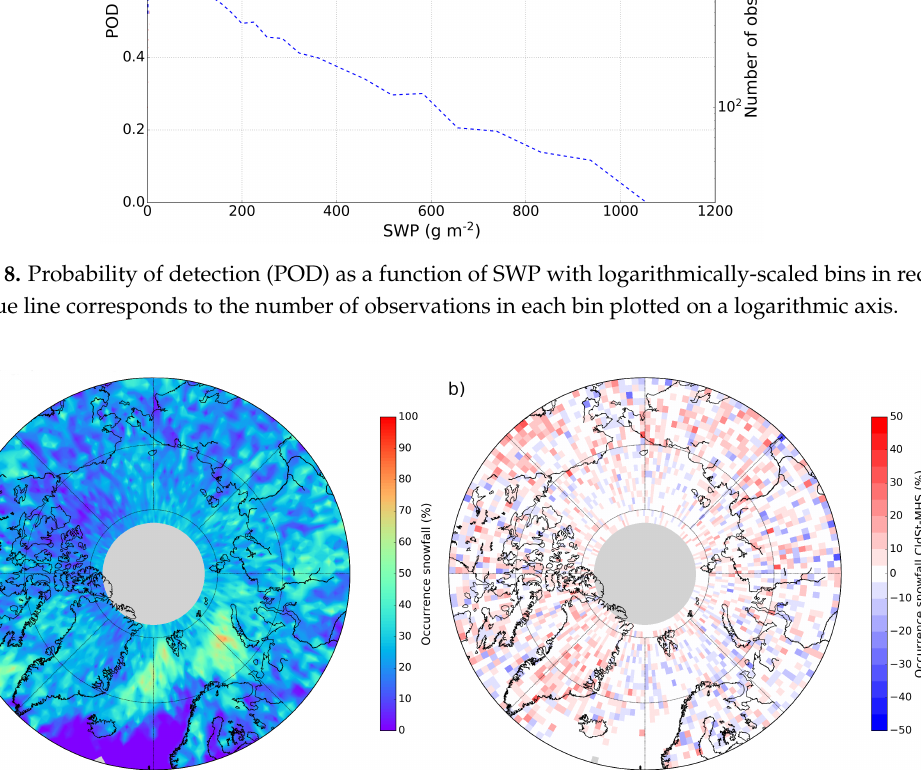
Figure 9. ( a ) The snowfall occurrence obtained using the MHS algorithm. The snowfall occurrence is defined as the number of algorithm-detected snowfall profiles divided by the total number of profiles (%) over a 1 ◦ latitude × 2 ◦ longitude grid. Grey cells are plotted where no data are available. ( b ) Differences between the snowfall occurrence (%) of CloudSat and that retrieved (%) by the RF algorithm using MHS. Profiles from the testing dataset were used and represent 20% of the entire CPR-MHS dataset. Of the 210,891 profiles used, 56,668 were classified as snowfall profiles by CloudSat and 52,871 were classified as snowfall profiles by